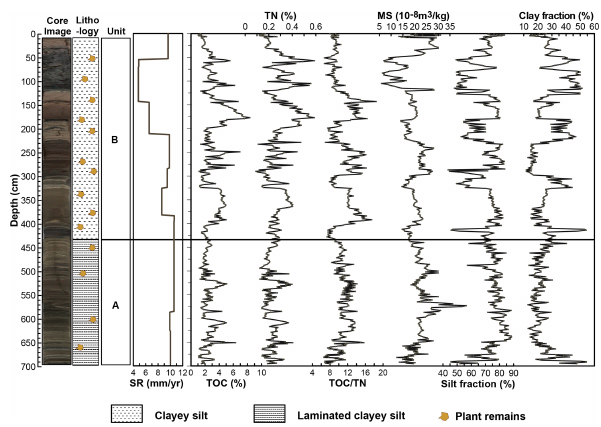
Figure 2. Sedimentary lithology and multi-proxy variation versus depth for the composite DLC1819